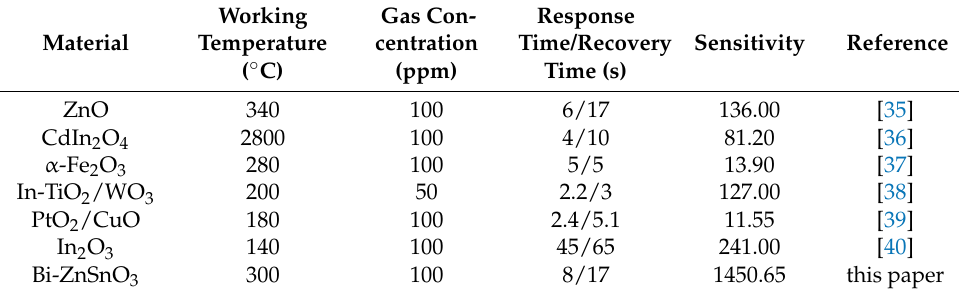
Table 2. Performance comparison of n -butanol gas